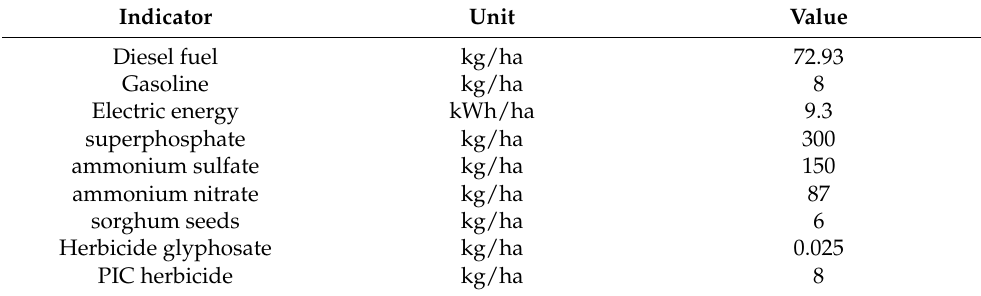
Table 11. Input material and energy flows.